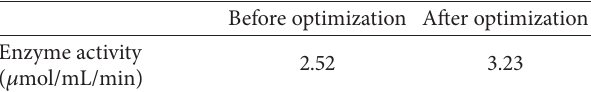
Table 5: Comparison of enzyme activity obtained before and after optimization where 28% higher activity was obtained for optimized asparagine dextrose salt